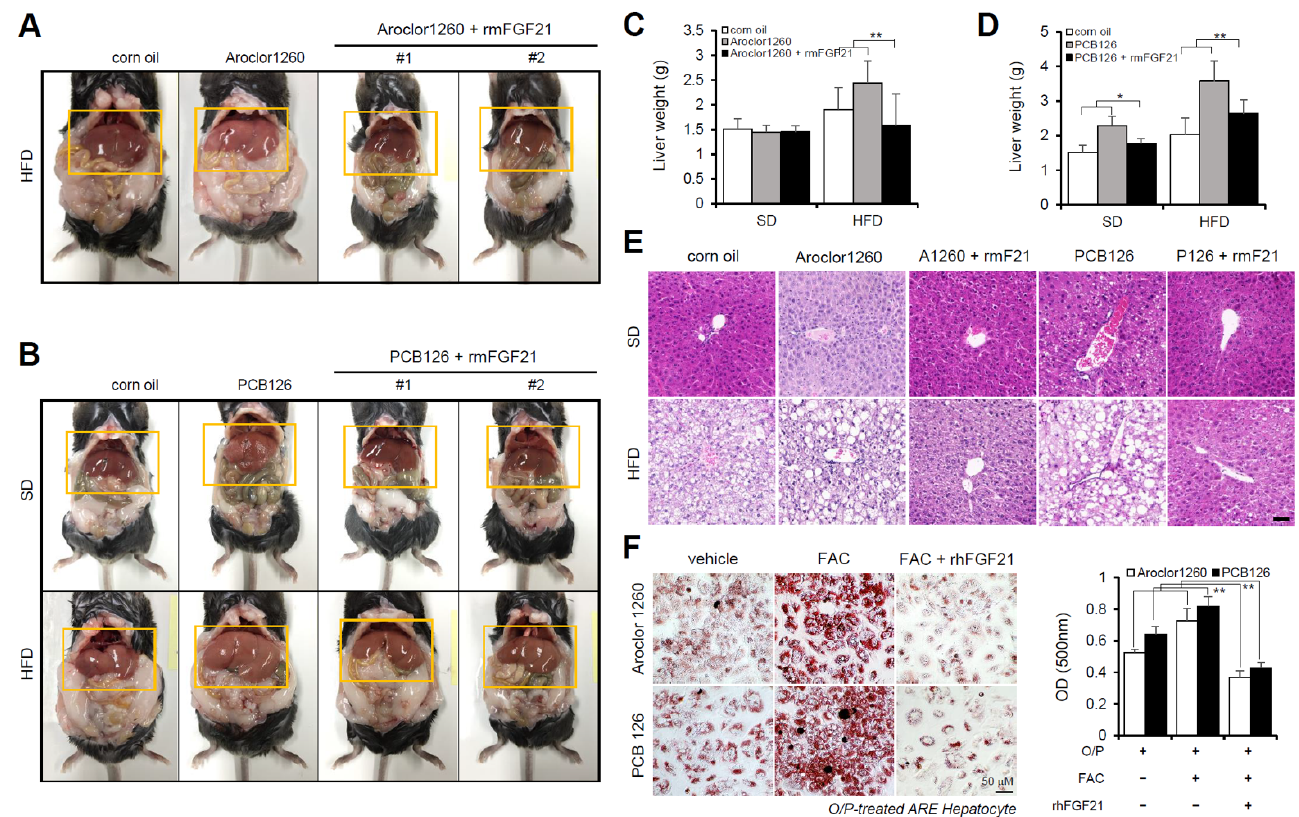
Figure 4. Recombinant FGF21 improves hepatic steatosis in PCB-induced NAFLD/NASH models. Aroclor1260- or PCB126-injected mice fed either a SD or HFD were intraperitoneally administered vehicle or rmFGF21 (1 mg/kg/day) once daily for 10 days. ( A , B ) Representative photograph images. ( C , D ) Liver weight. ( E ) H,E staining of liver tissue. Scale bar: 50 µ m. ( F ) ORO staining and quantification showing that rhFGF21 (50 ng/mL, 24 h) reduced the hepatic lipid accumulation induced by both 20 µ M Aroclor1260 and 10 µ M PCB126 in O/P-treated human ARE primary hepatocytes. Scale bar: 50 µ m. All values represent the mean ± SD, n = 4. * p < 0.05, ** p < 0.01 compared with the experimental control.